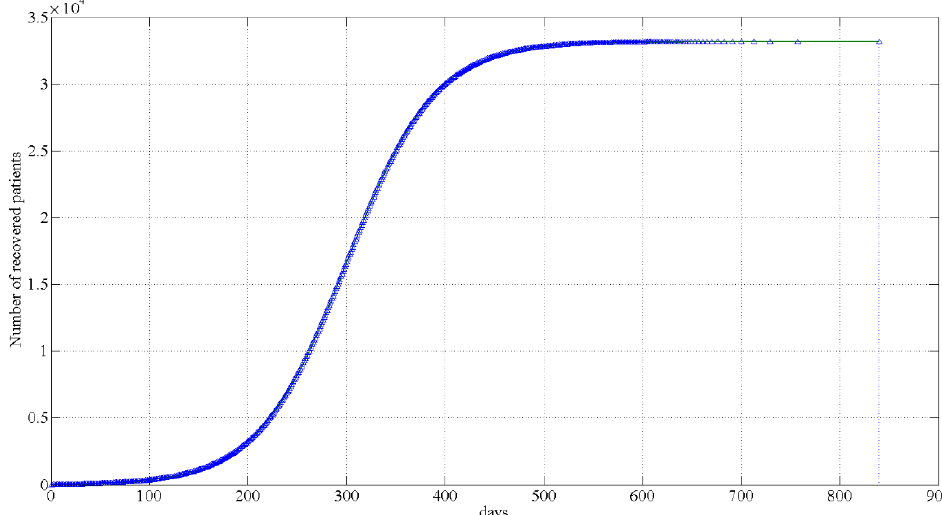
Figure 5. Changes in the number of recovered patients from Strategy 6.